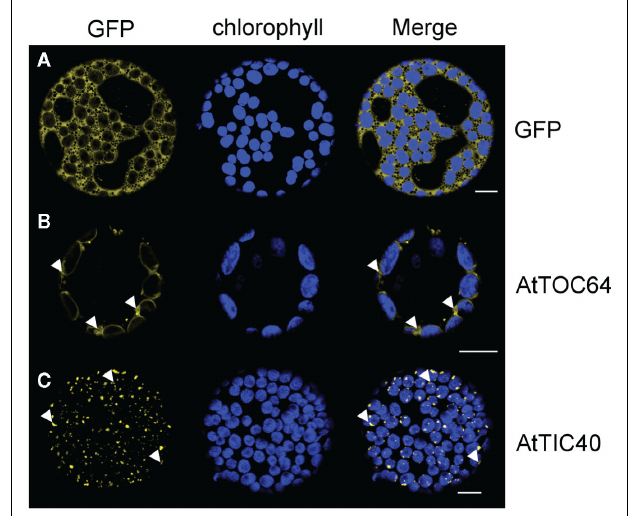
FIGURE 1 | GFP-fusion protein expression patterns in N. benthamiana protoplasts. Confocal microscopic analysis on isolated protoplasts of N. benthamiana leaves after 35S-promoter driven in planta expression of GFP-fusion proteins. Pictures were taken 48h after infiltration. GFP fluorescence (GFP) in yellow, chlorophyll autofluorescence (chlorophyll) in blue and an overlay (merge) of representative protoplasts are shown. (A) Expression pattern of cytosolic GFP. (B) Expression pattern of AtTOC64-III-GFP in ring structures around the chlorophyll autofluorescence with slide GFP labeled extensions (arrowheads). (C) Expression pattern of AtTIC40–GFP in dots associated with the autofluorescence. Crescent moon-like structures can be seen (arrowheads). Size bars: 10 μ